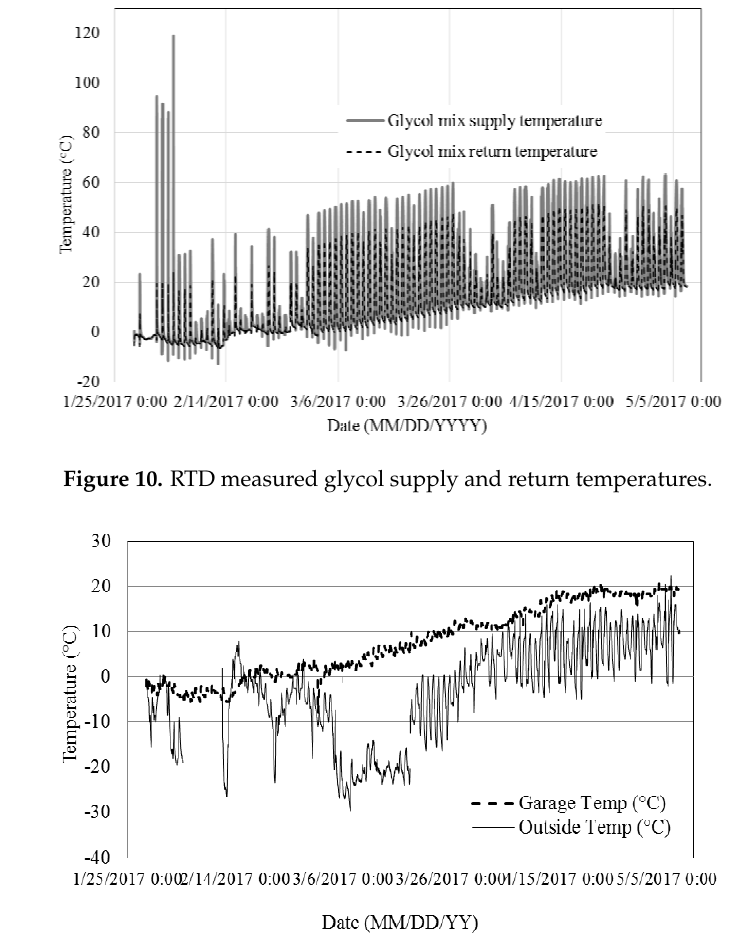
Figure 11. Ambient outside and garage temperature as measured.